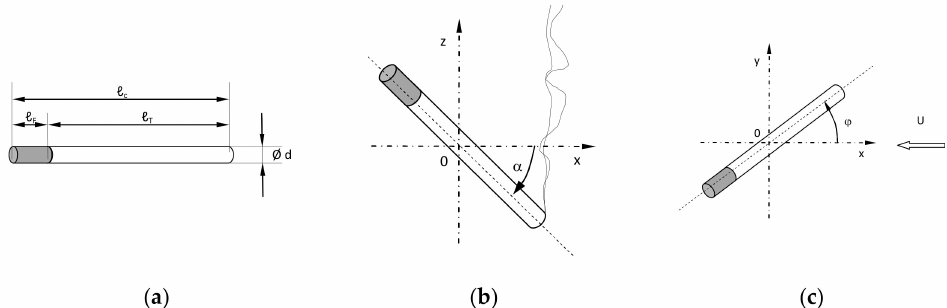
Figure 2. ( a ) Geometric properties of a cigarette; ( b ) Definition of inclination angle α ; ( c ) Definition of angle ϕ for a cigarette in the horizontal plane ( α = 0º) subject to a flow with characteristic velocity U